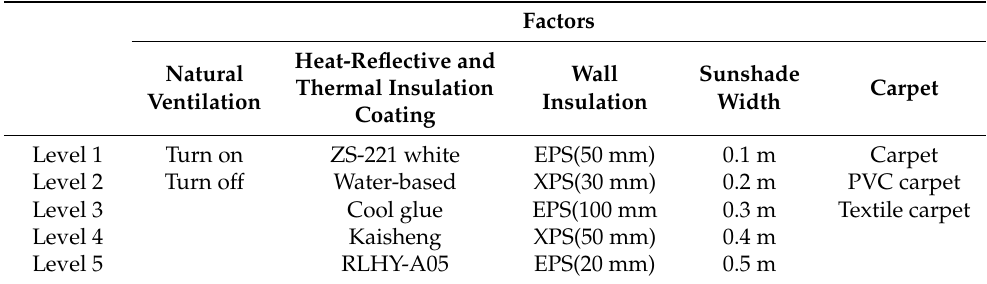
Table 5. Factor-level table of the orthogonal experiment design of the